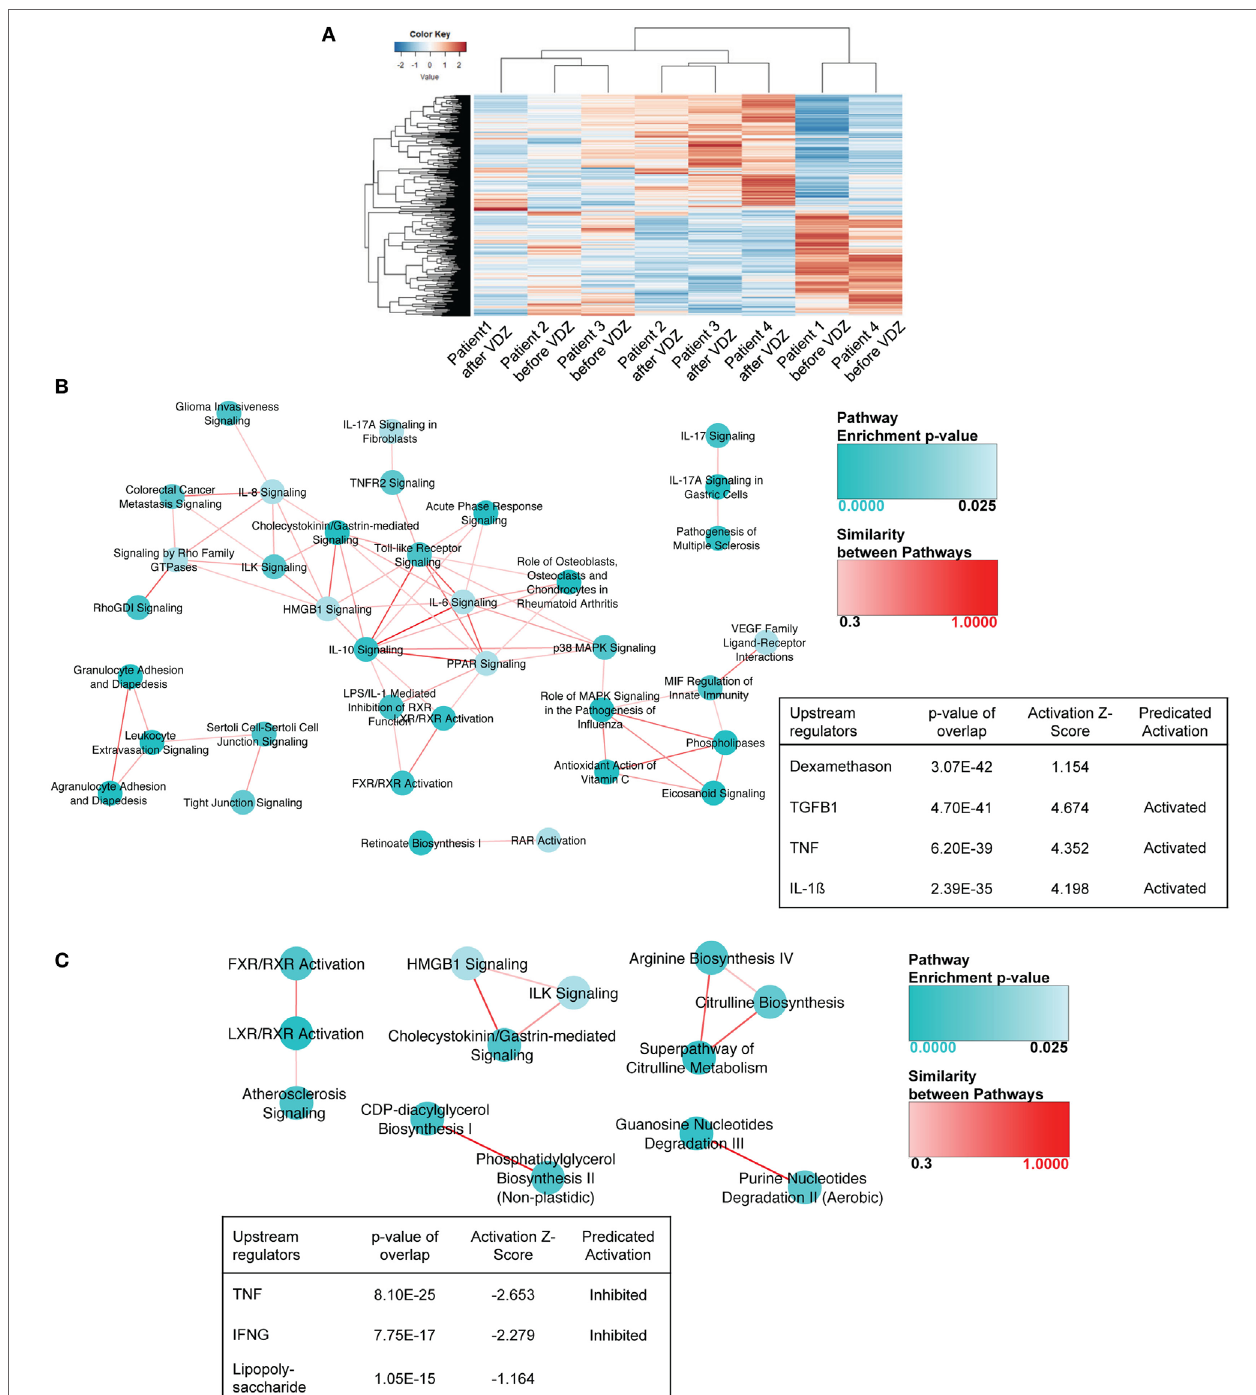
FigUre 2 | RNA sequencing in patients with ulcerative colitis (UC) under treatment with anti- α 4 β 7 therapy with vedolizumab (VDZ). (a) Unsupervised hierarchical clustering of the expression profiles of differentially expressed genes upon VDZ therapy. (B) Canonical pathways and upstream regulators in UC patients with no remission to VDZ therapy. Ingenuity Pathway Analysis (IPA) of the differentially regulate genes in UC before and after VDZ therapy revealed granulocyte and agranulocyte adhesion and diapedesis to be among the three most significantly regulated pathways and TGF β 1 and TNF were among the three most significantly regulated upstream regulators with a predicted level of activation. (c) Canonical pathways and upstream regulators in UC patients with remission to VDZ therapy. In VDZ remitters, LXR/RXR activation and guanosine nucleotides degradation III were the most significantly regulated pathways on IPA and TNF and IFN γ as pro-inflammatory cytokines and upstream regulators were predicted to be inhibited in UC patients with remission to VDZ therapy. Turquoise dots represent pathway enrichment p -values; similarity of the pathways is represented by red